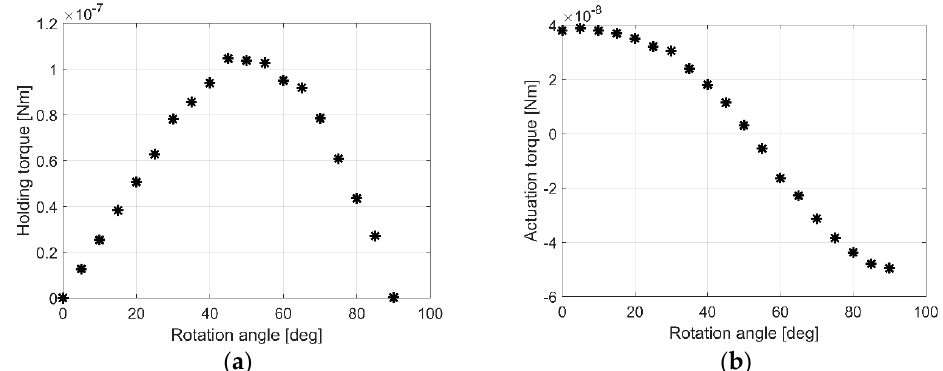
Figure 4. ( a ) Holding and ( b ) actuation torque calculated for the prototype.